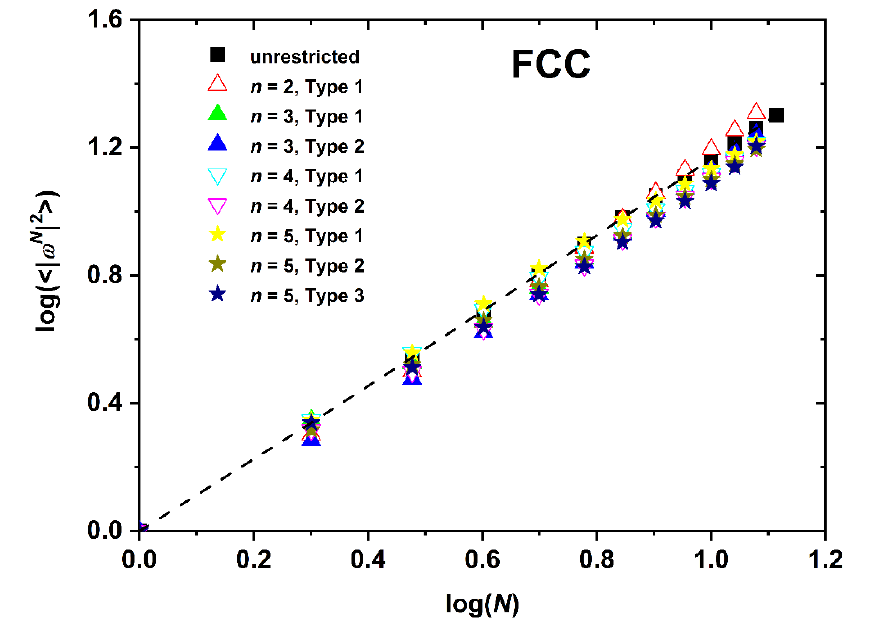
(cid:12) (cid:12) 2 (cid:105) (cid:12) (cid:12) , as a function of the (cid:12) ω N (cid:12)